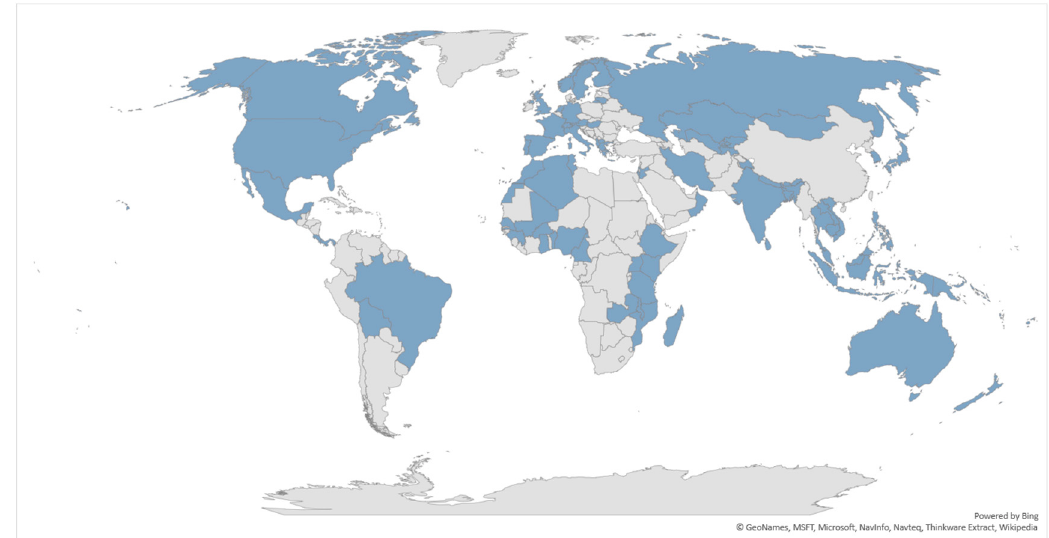
Figure 2. Countries that have completed a national climate change and health vulnerability and adaptation assessment. Not visible on the above map: Antigua and Barbuda, Barbados, Brunei, Cook Islands, Dominica, Federated States of Micronesia, Fiji, Grenada, Kiribati, Maldives, Malta, Marshall Islands, Nauru, Niue, Palau, Samoa, Solomon Islands, St. Lucia, Timor-Leste, Tonga, Tuvalu, and Vanuatu.